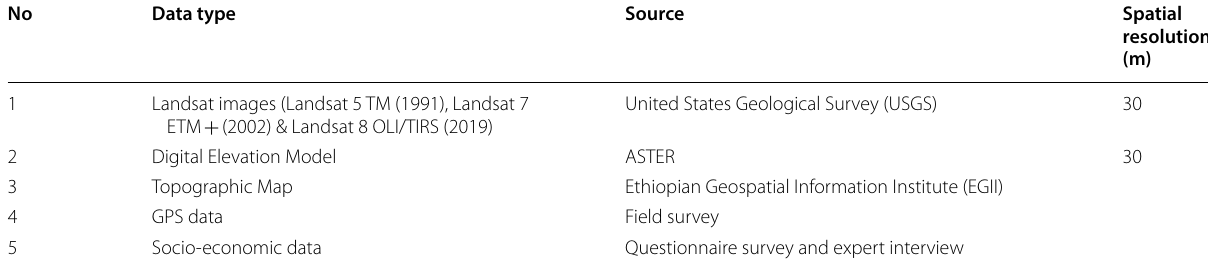
Table 2 Data types and sources